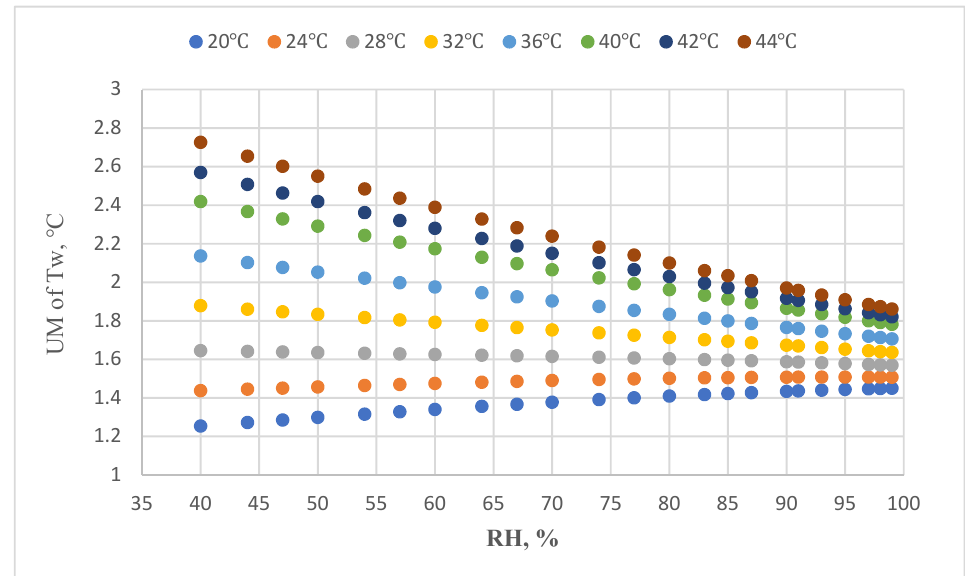
Figure 7. The expanded measurement uncertainty for different Td and RH values if the Td and RH sensors are not calibrated.